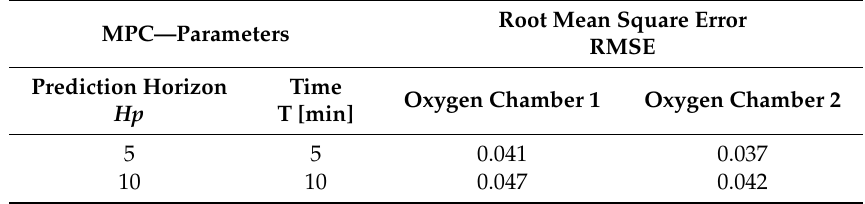
Table 7. RMSE prediction error with preset parameters Hp , T in oxygen chambers 1, 2 of the biological reactors.